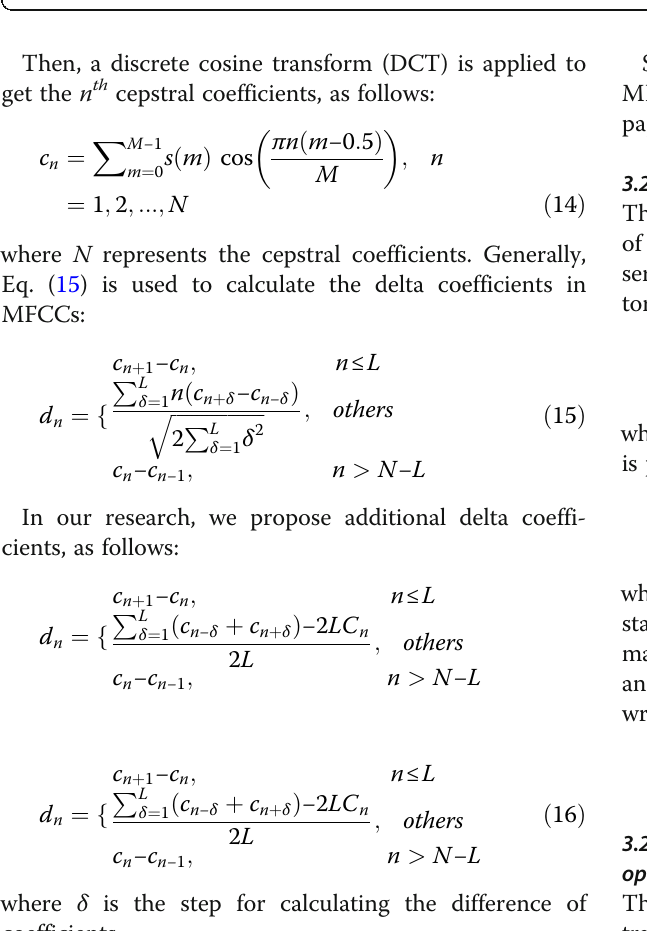
Fig. 10 Feature extraction procedure using MFCC